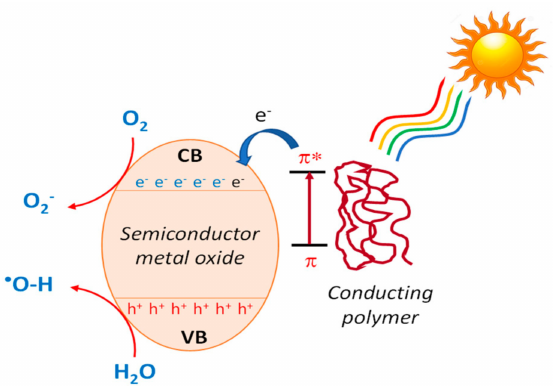
Figure 16. Schematic illustration of the mechanism of action of hybrid materials obtained by the combination of conductive polymers to semiconductor metal oxides.